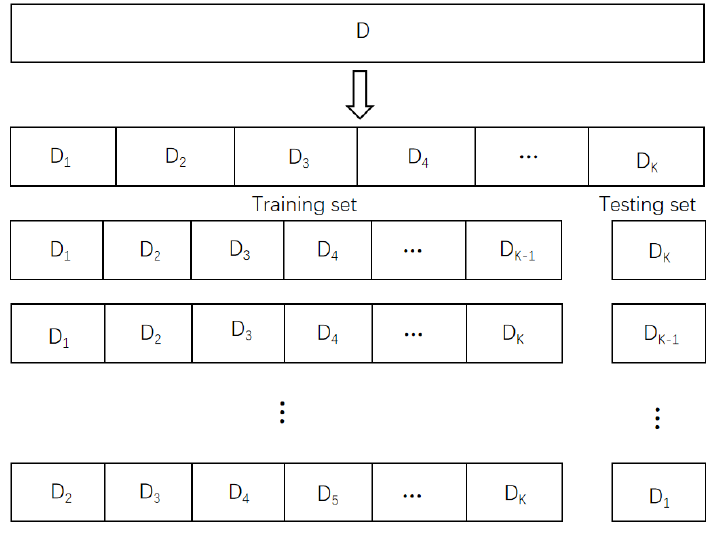
Figure 7. Dataset splitting.